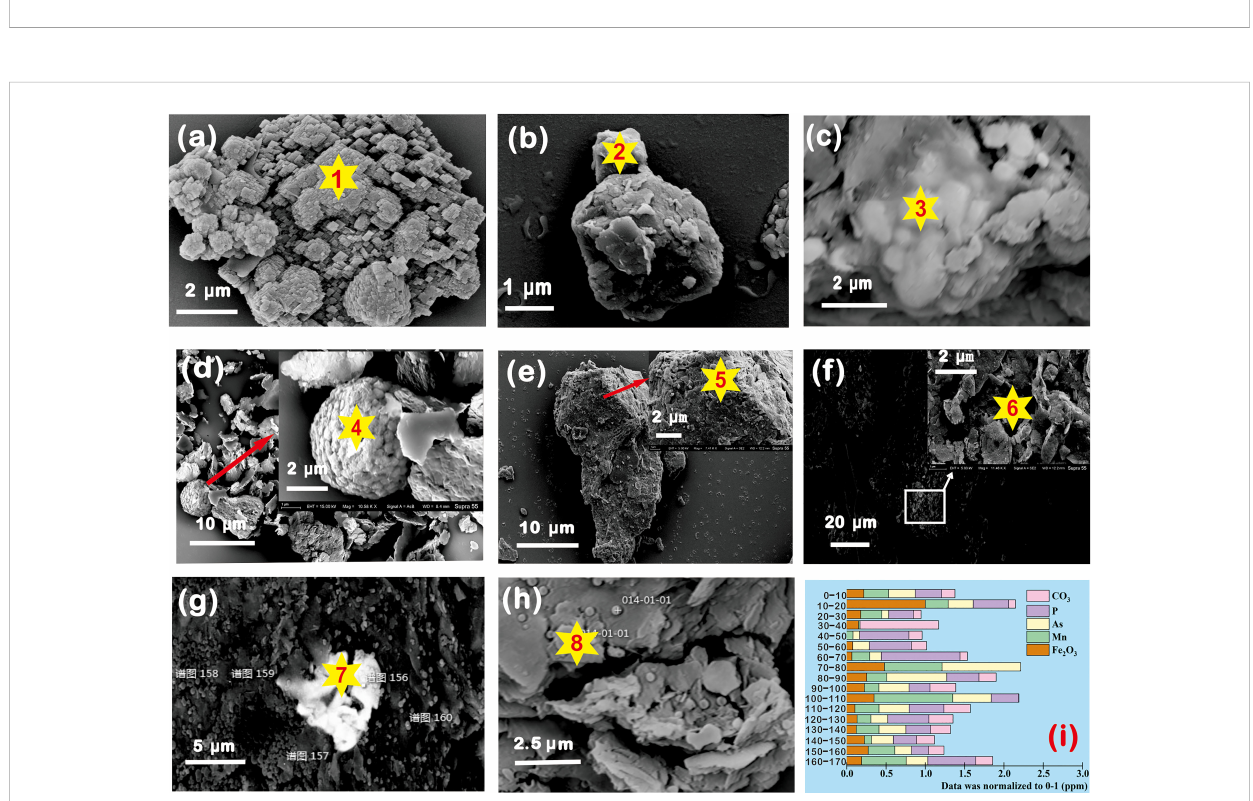
FIGURE 4 Emission-scanning electron microscope (SEM) images of different iron speciations in vertical pro fi le. (A) : 40-50 cm; (B – D) : 70-80 cm; (E) : 80-90 cm; (F) : 90-100 cm; (G) : 130-140 cm; (H) : 160-170 cm and (I) : Normalized relative abundance of partial major elements based on X-ray Fluorescence Spectrometer